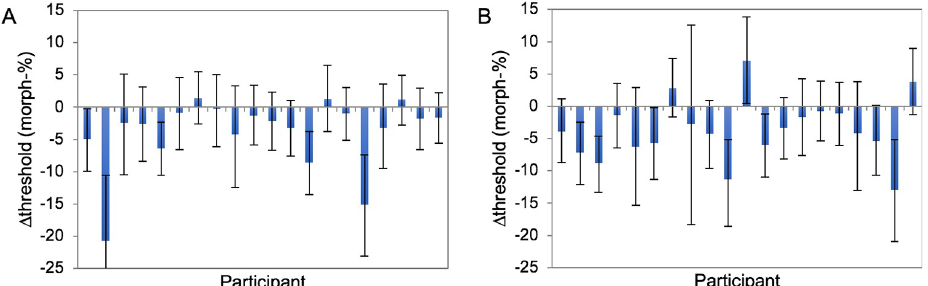
Fig 7. The threshold change induced by the more saturated red color, for all participants. (A) Facial color condition, (B) background color condition (exp IIb). Error bars represent the 95% confidence intervals derived from